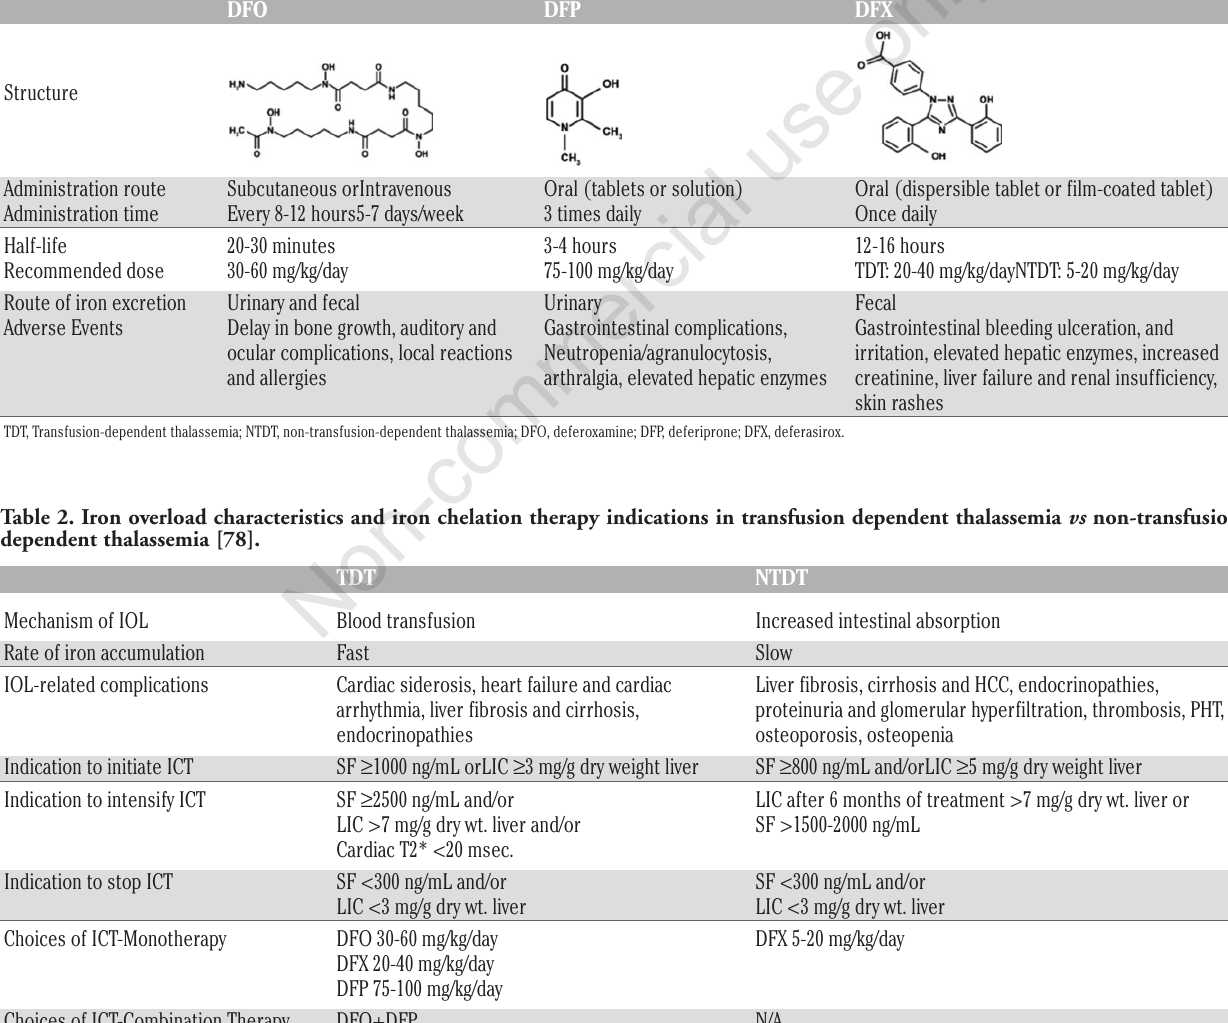
Table 1. Characteristics of the currently available iron chelators in thalassemia management [2, 77]. DFO